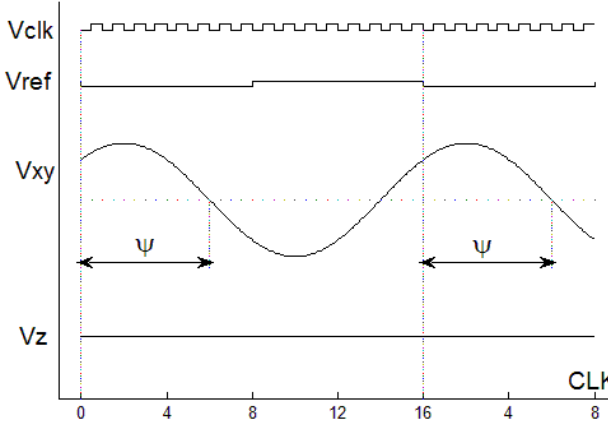
Figure 4. The output voltage of the device when constant magnetic field B is